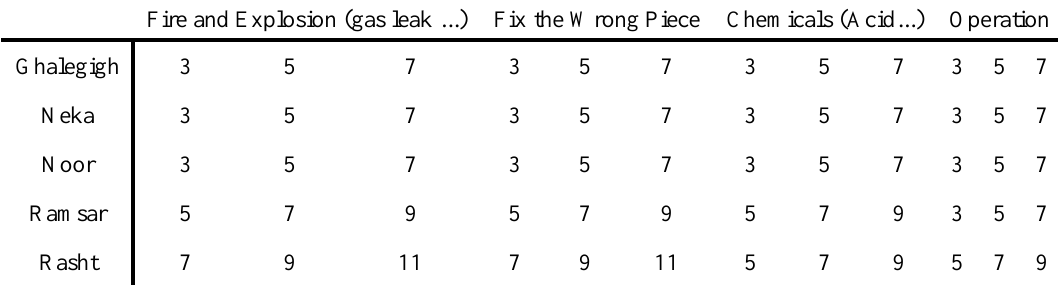
Tables 12. The fuzzy inventory results for the equipment safety standard versus gas facility. Fix the Wrong Piece Chemicals (Acid...)